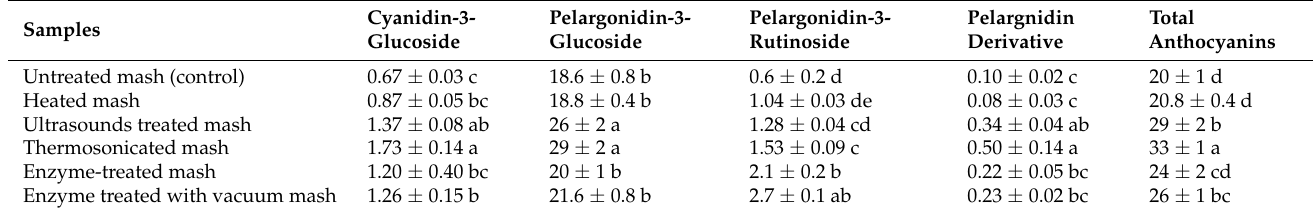
Table 2. Effect of mash treatment on anthocyanins content (mg/100 g f. w.). Cyanidin-3- Glucoside